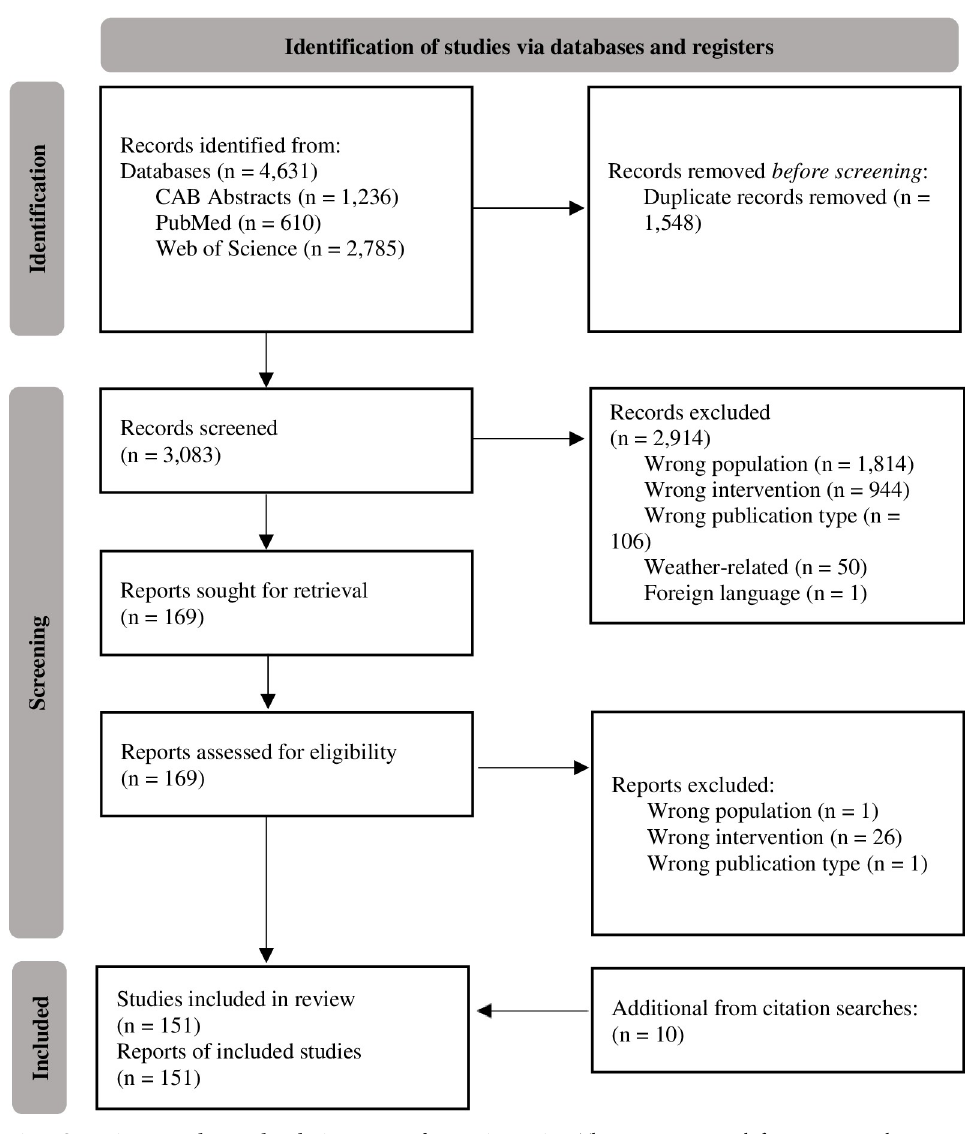
Fig 1. Screening procedure and exclusion process for scoping review. The aim was to search for experimental papers with a population of farmed animals and an intervention of hiding place.